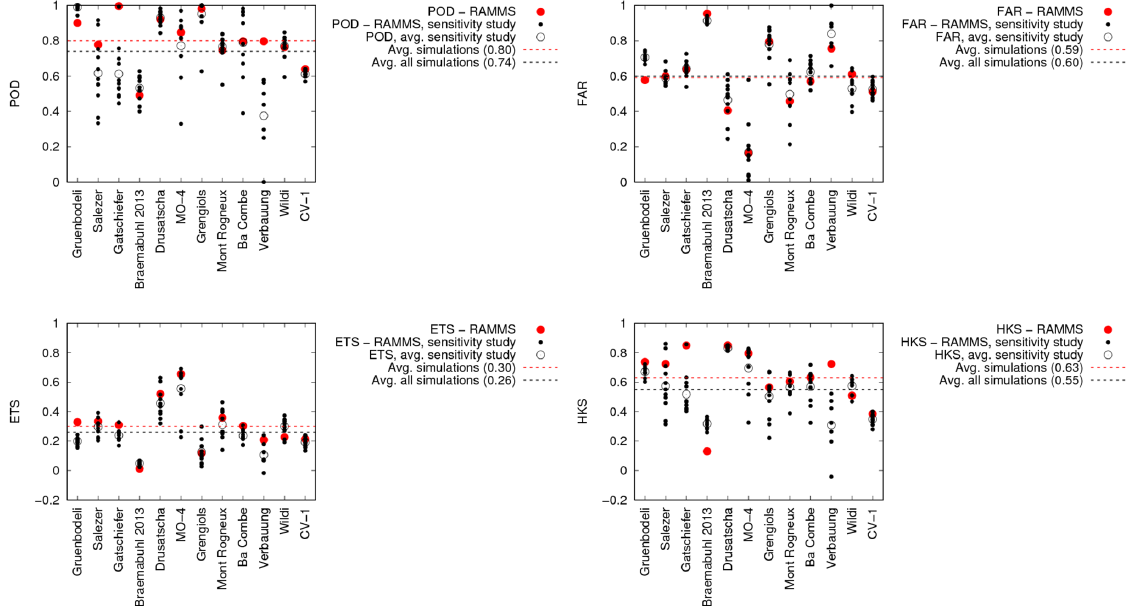
Figure 8. Sensitivity study simulating every avalanche path with the 12 different initial and boundary conditions, but with a simulation resolution (grid size) of 10m for the 144 simulations (compare to Fig. 5 for 3m resolution). Markers and colors as in Fig.